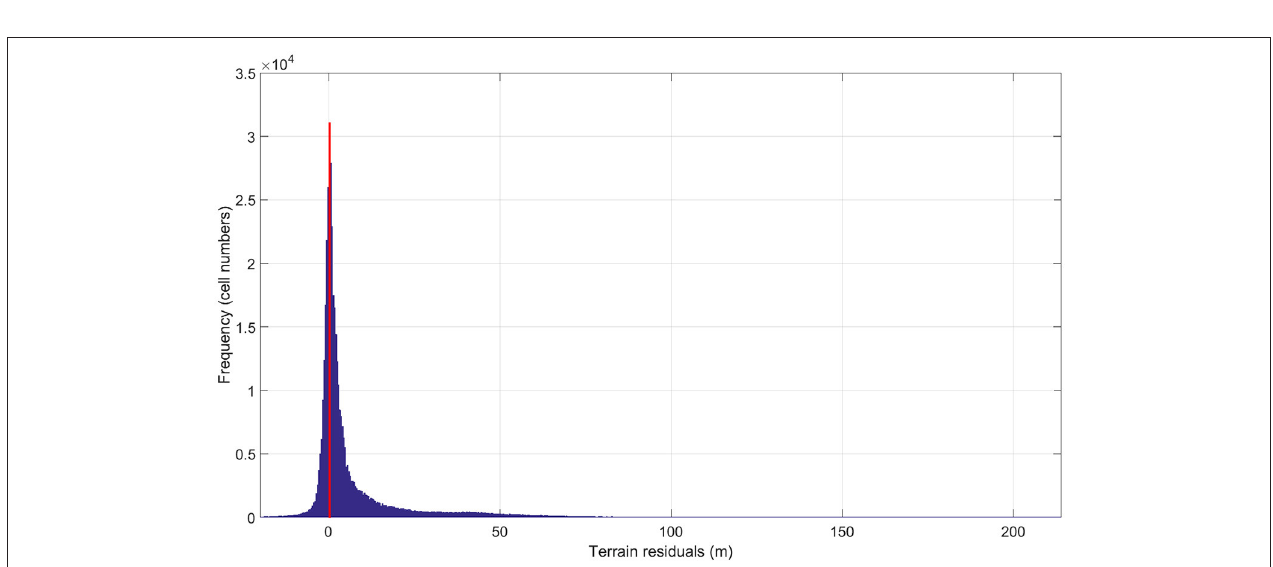
FIGURE 7 | Histogram plot of change in elevation obtained by differencing the 2015 and 2005 DEMs after improvement of the coregistration. The peak centered on zero proves their accurate alignment.